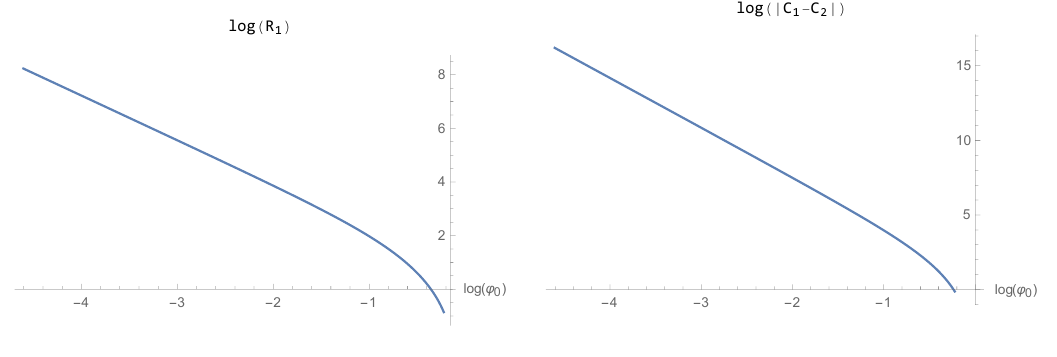
Figure 13 . R 1 ( ’ 0 ) and C 1 ( ’ 0 ) (cid:0) C 2 ( ’ 0 ) in the case where the sphere 1 shrinks and for T 2 ; 0 = 0. In this situation the space 2 is (cid:13)at ( R 2 =